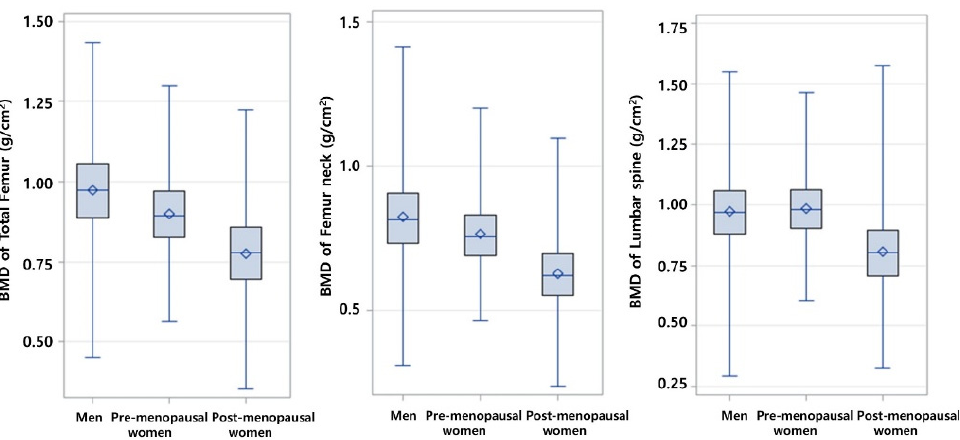
Figure 2. BMD by site (total femur, femur neck, lumbar spine) for male, and pre- and postmenopausal females .